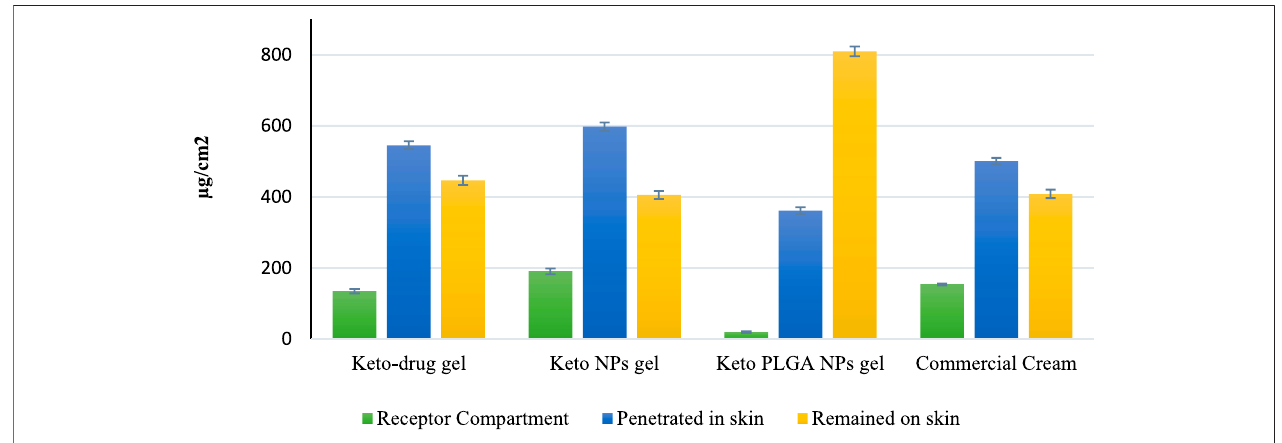
FIGURE 5 | Ex vivo studies on the human abdominal skin. Comparison of drug concentration at different levels of human skin. Mean ± standard deviation ( n = 3).